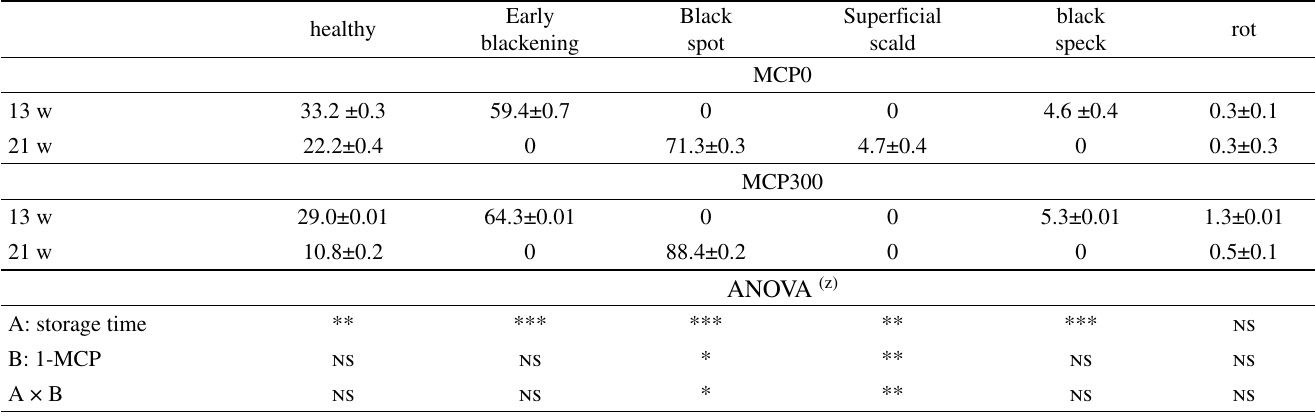
Table 4 - Storage disorders in control (MCP0) and 1-MCP treated (MCP300) ‘Conference’ pears after 13 and 21 weeks of storage and 7 days of shelf life at 20°C and ANOVA results (n=3)